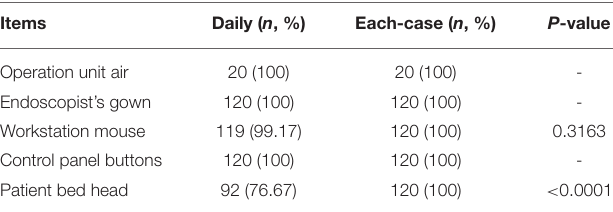
TABLE 1 | The qualified rate of cultured samples from the surface of endoscopy unit items between the daily and the after-each-case room disinfection groups.